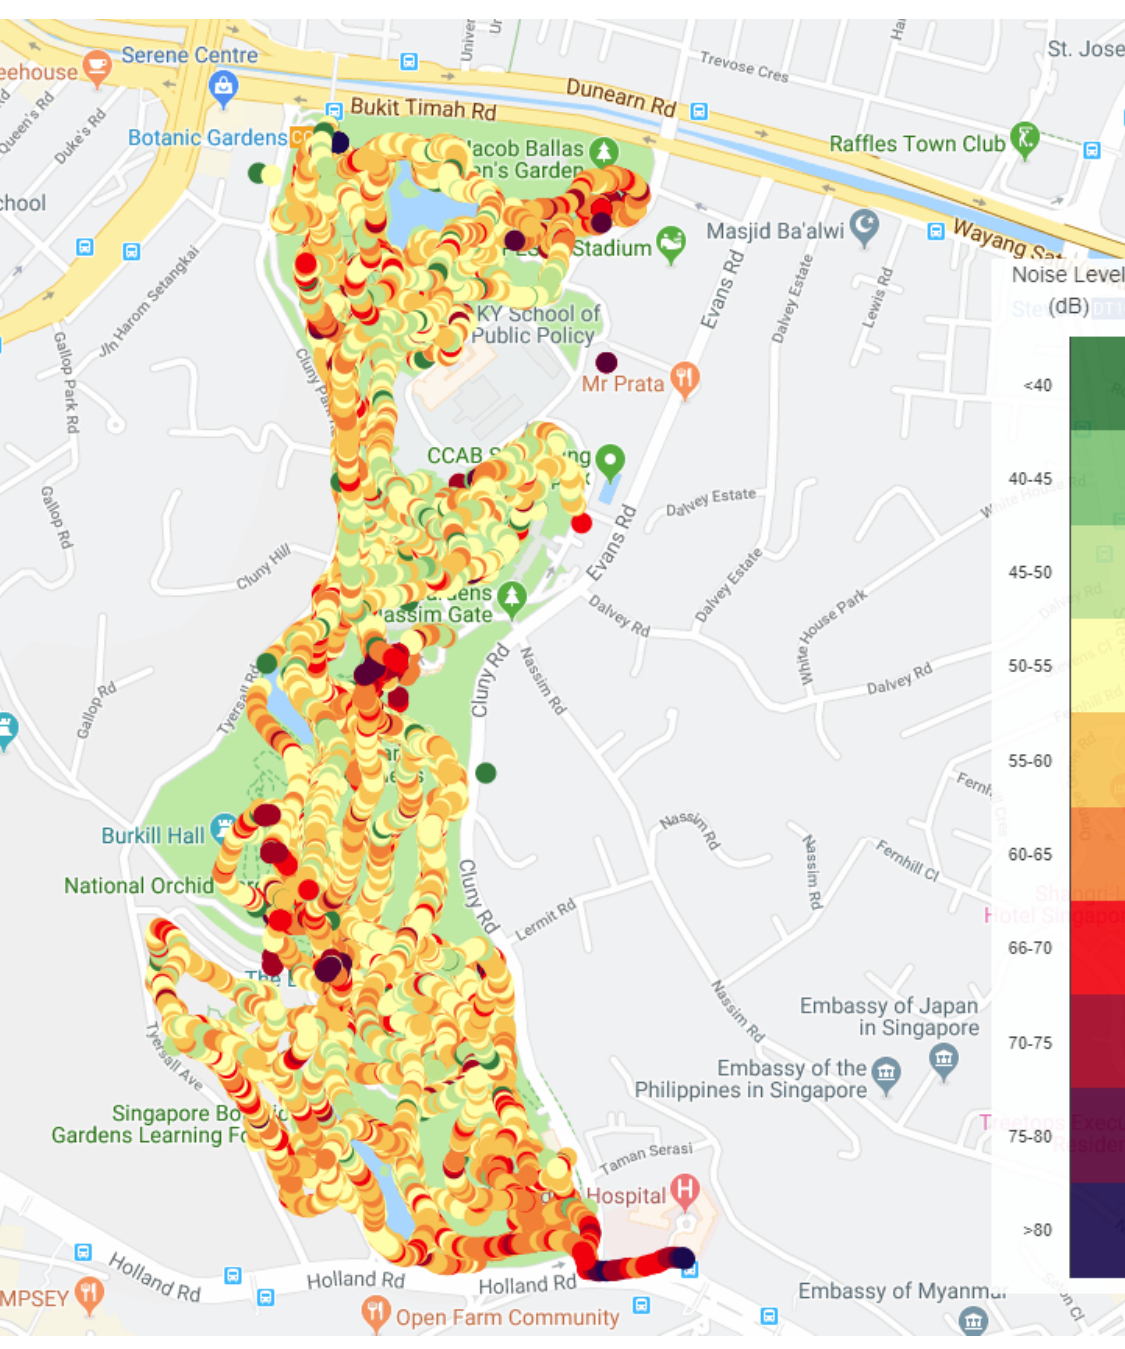
National Orchid Centre (Figure 4) where there is a clock tower and visitors to the park, in particular visitors and tourists like to congregate at this spot to take group photos. The last noisy spot is the lower right-hand corner near the main entrance, namely the Tanglin Gate to the Gardens at the junction of Cluny Road and Holland Road. The sonic